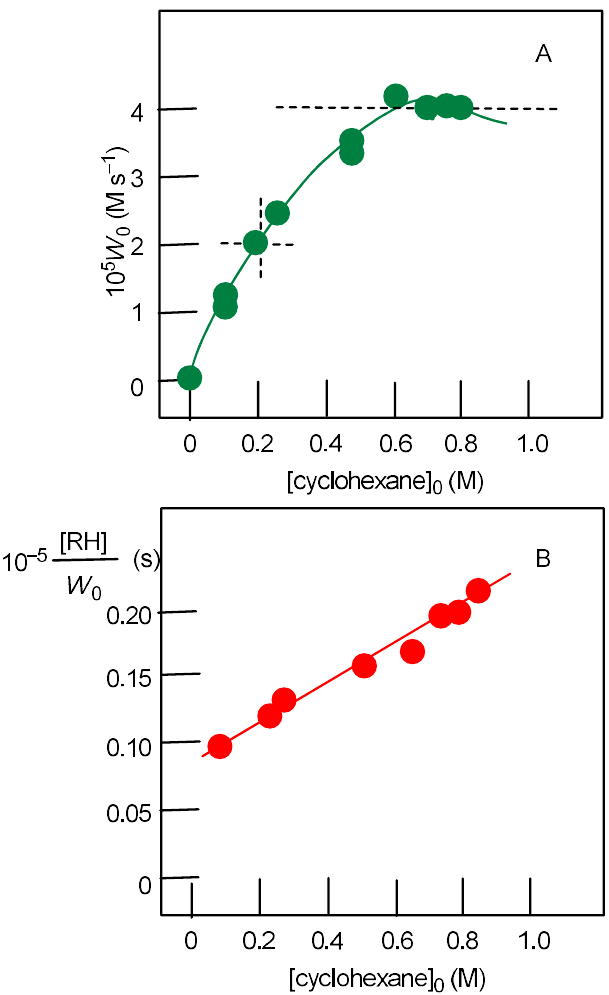
Figure 6. The dependence of the oxidation rate W 0 on the initial concentration of cyclohexane in the oxidation of cyclohexane into cyclohexanol and cyclohexanone (a sum) with H 2 O 2 (2.0 M) catalyzed by complex 1 in the presence of HNO 3 (0.05 M). Conditions: catalyst 1 (5 × 10 −4 M), 50 °C, concentrations of products were measured by GC only after the reduction of the reaction sample with solid PPh 3 . Linearisation of the curve shown in Graph A is presented in Graph B .